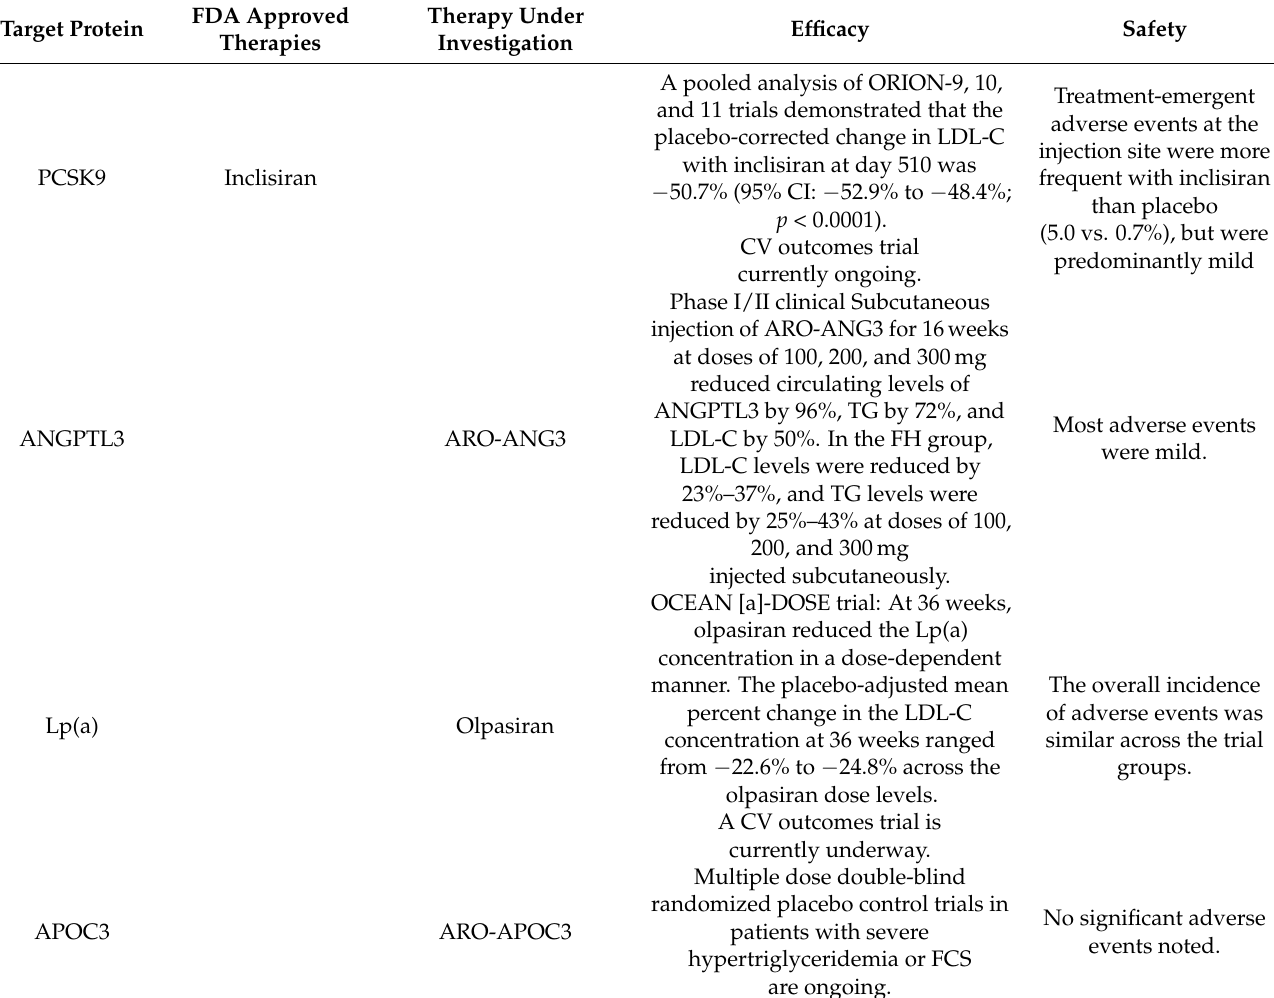
Table 3. Summary of short interfering RNA currently available or under